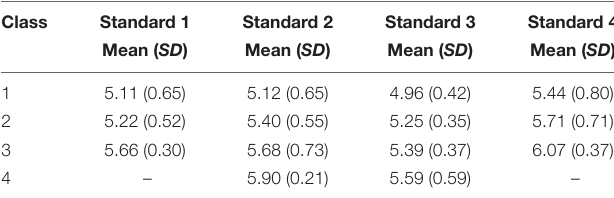
TABLE 5 | Centroid mean and standard deviation per class for each standard.